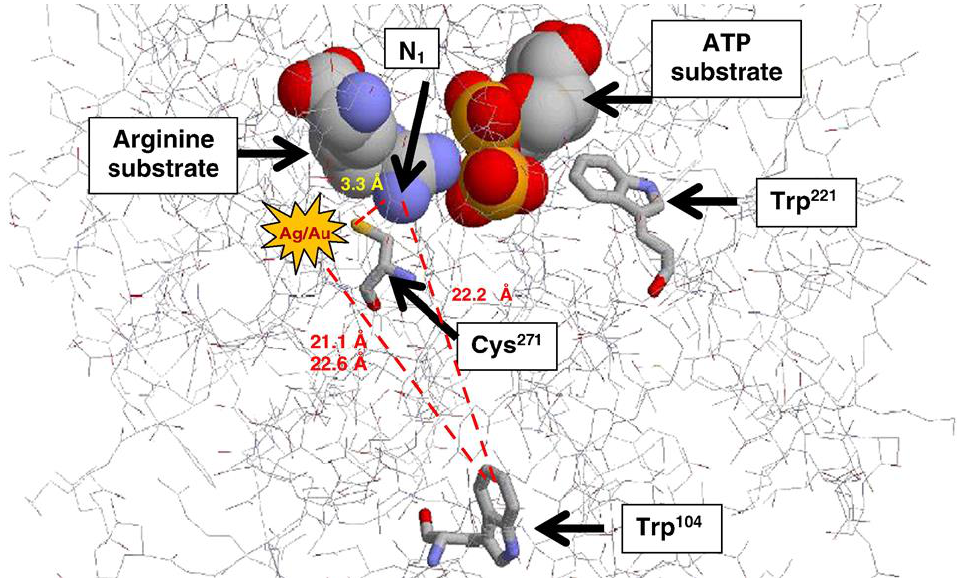
Figure 2. Mechanism of action for Ag/Au nanoparticles at cysteine of Trypanosoma . Proposed by Adeyemi and Whiteley [20] .